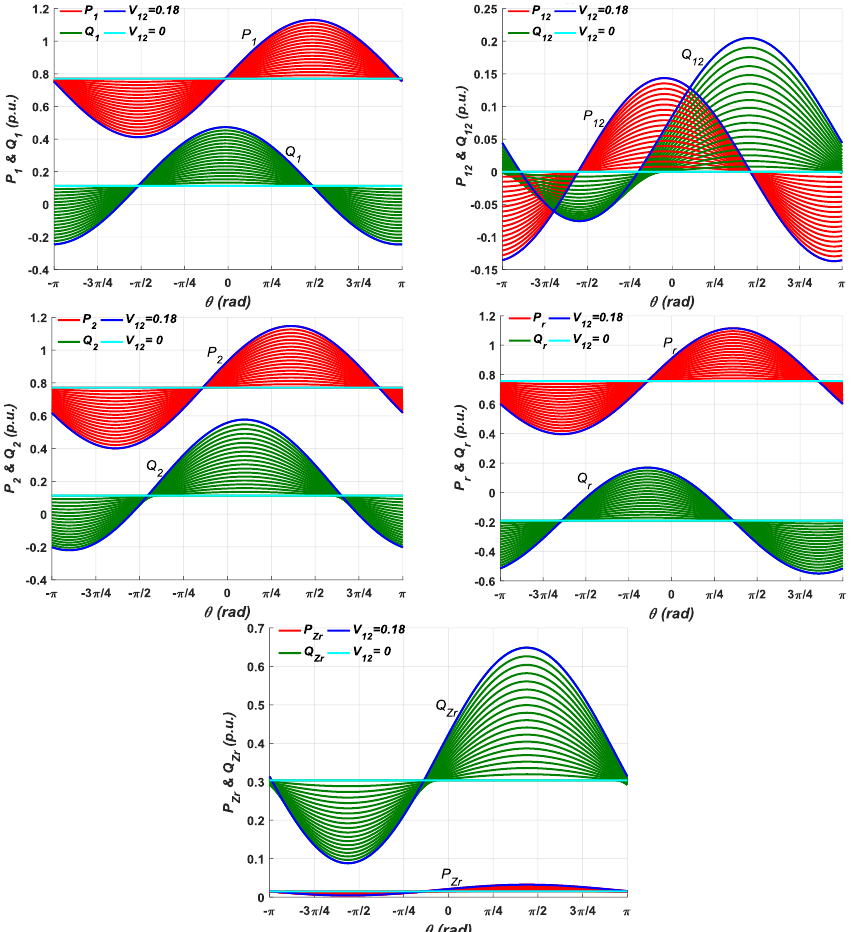
Figure 4. The 2-dimensional power flow planes against phase θ of each part when V r =1, δ = –π/8.